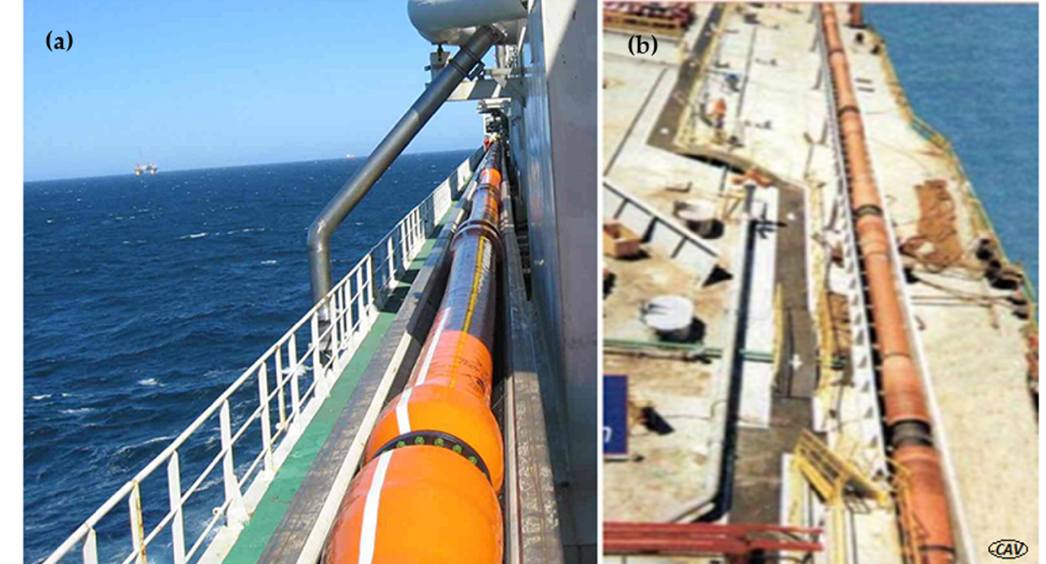
Figure 14. Two different hose storage systems in the chutes of floating FPSOs, showing (a) loading hose stowed on deck’s chute along the FPSO’s wall, which could also be a free-hanging catenary hose, and (b) loading hose stowed in the chute on a lower area of FPSO’s deck inside its deck trays between loadings, with the hose string winched onboard over a stern roller chute.